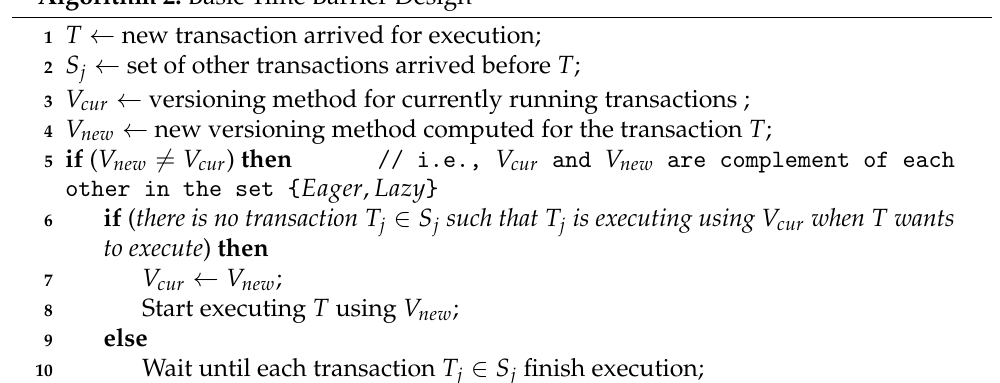
Algorithm 2: Basic Time Barrier